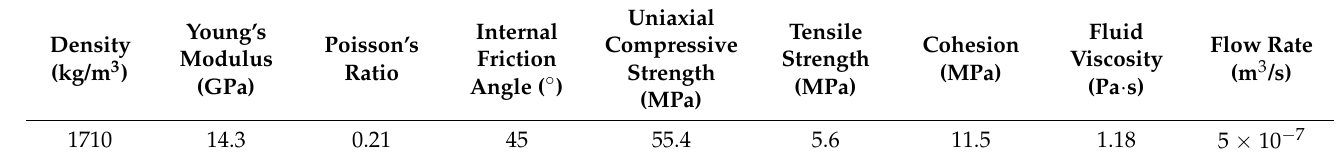
Table 1. Mechanical properties of hydrostone samples and experimental conditions in Abass et al.’s experiment